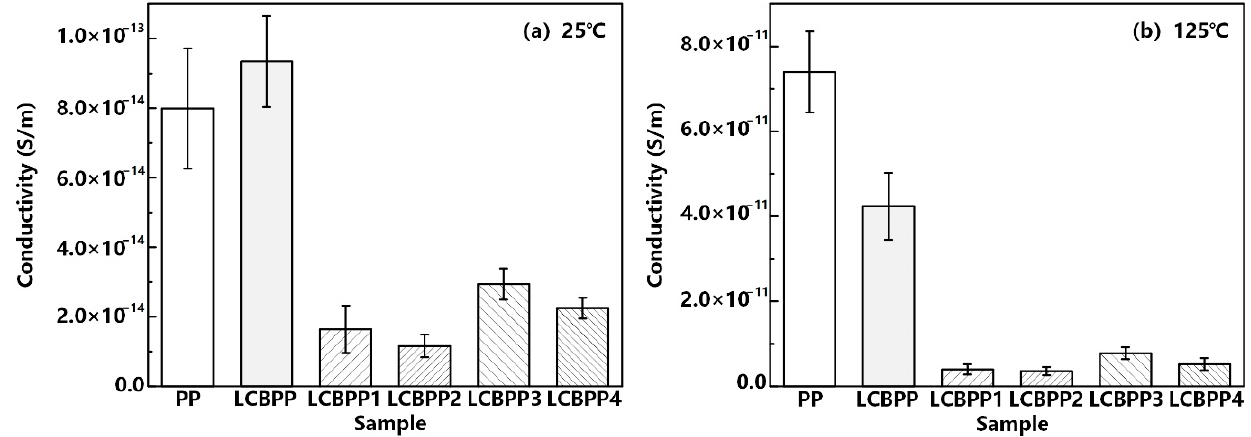
Figure 9. Relation between the conductivity and the α nucleating agents at different